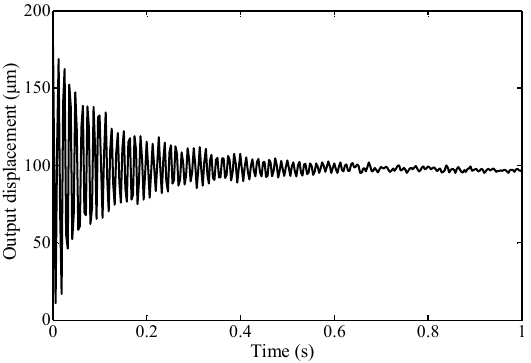
Figure 12. Response to step signal for system identification for the X direction.